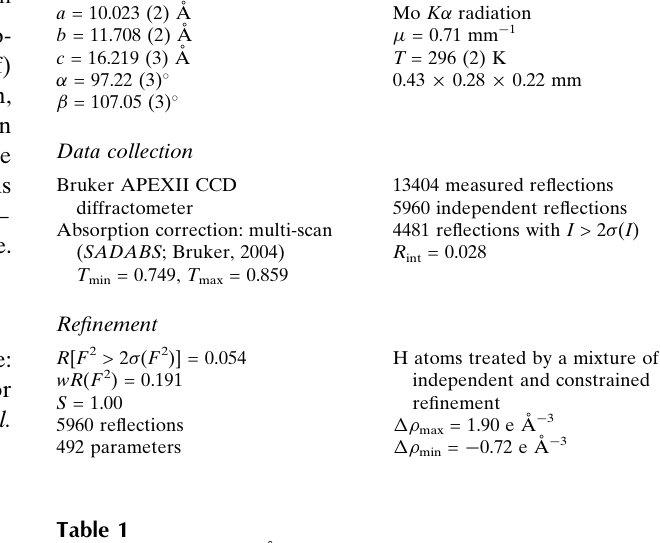
Selected bond lengths (A˚